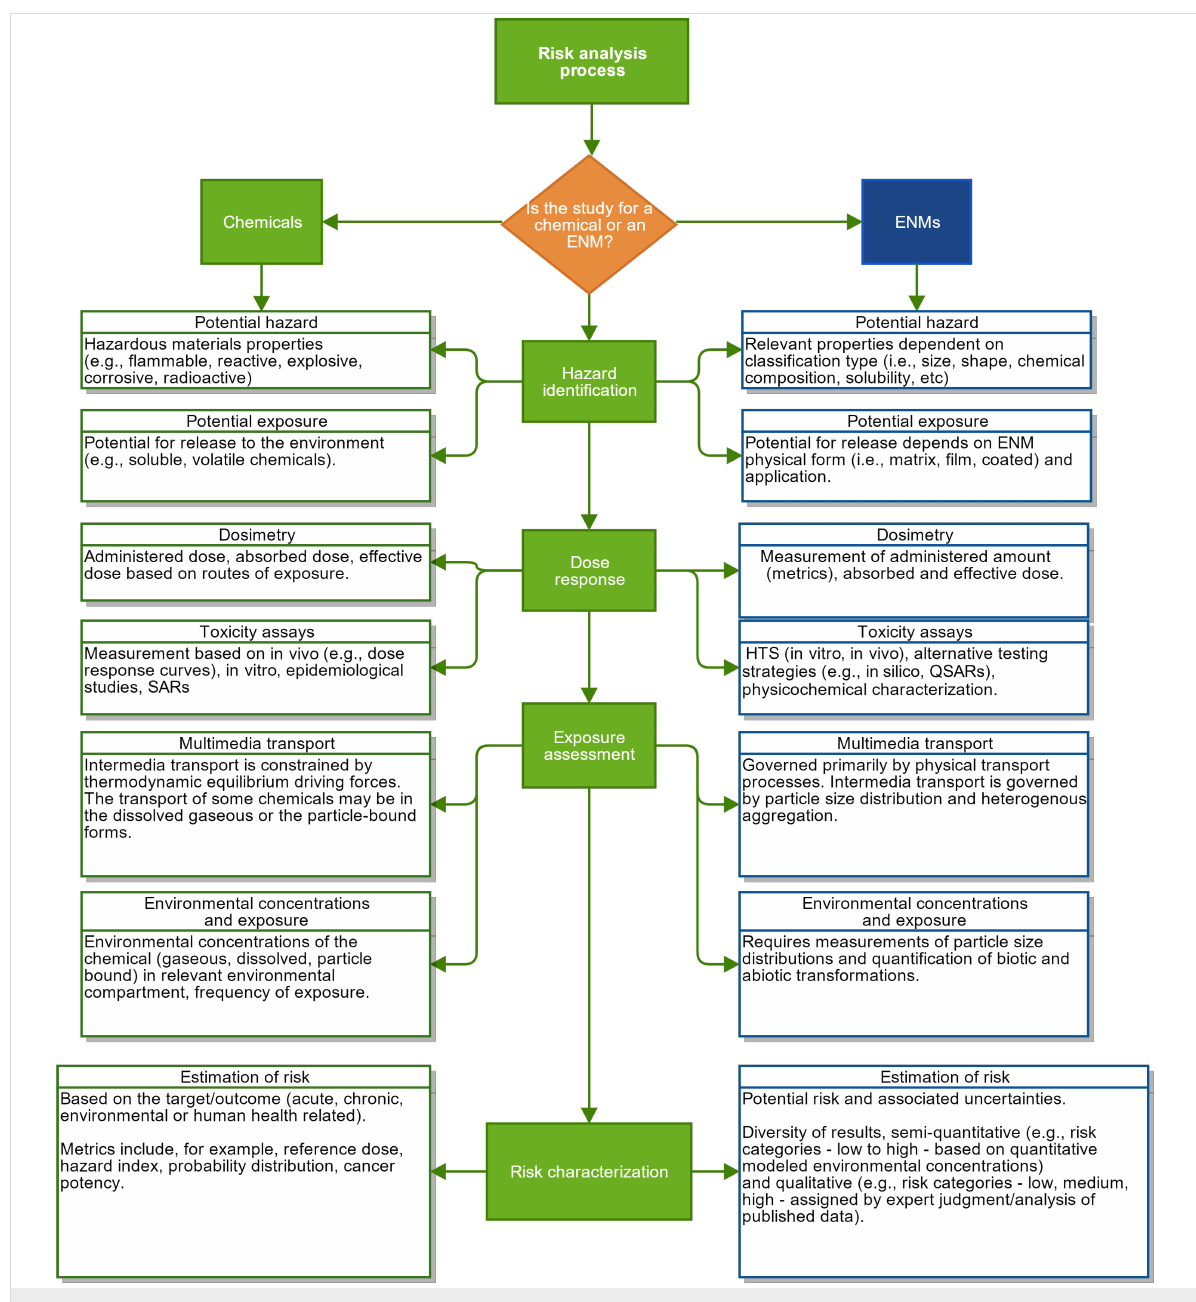
Figure 1: Challenges encountered at each step of the traditional risk assessment process for conventional chemicals and its relevance to ENMs.